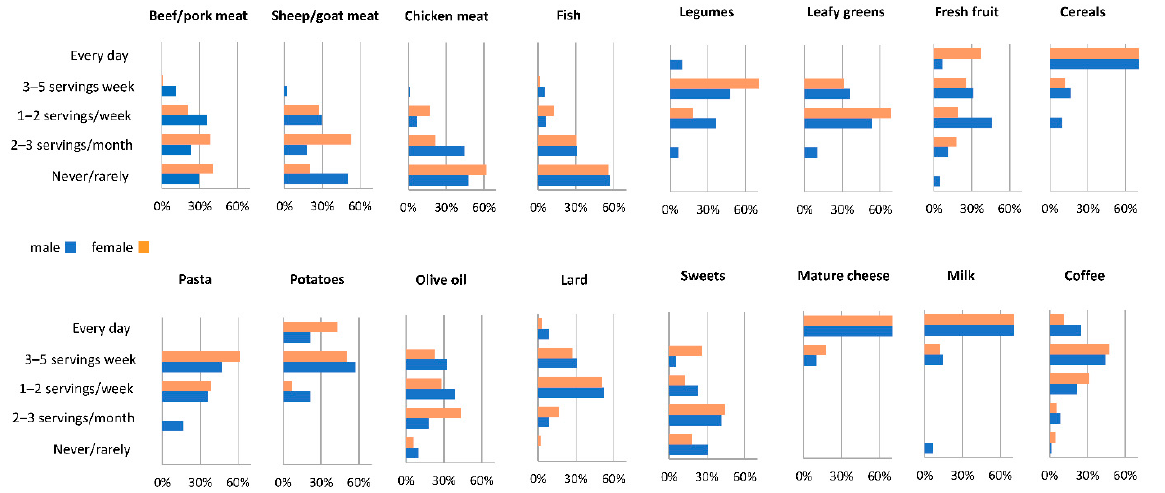
Figure 2. Percentage frequency of consumption of 16 food items among the study participants, reported in the x